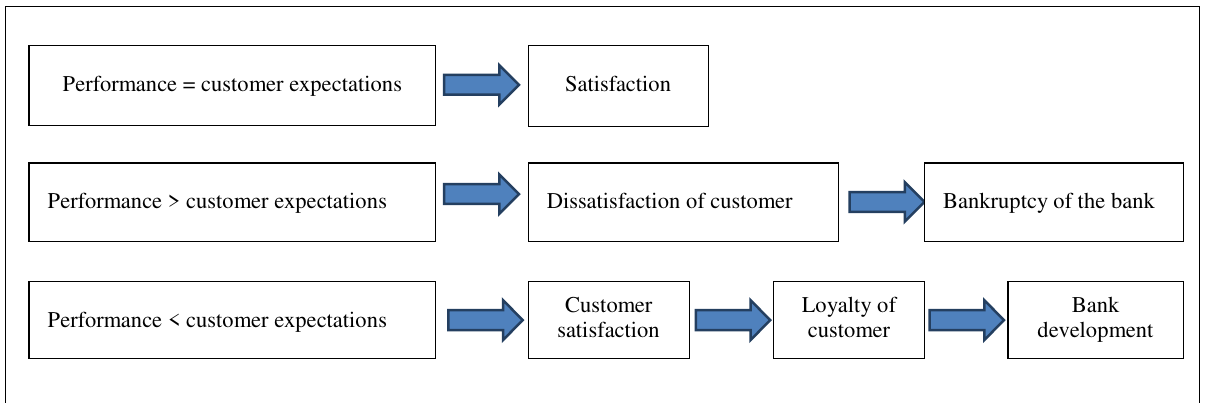
Fig. 2. Different states of the customer satisfaction